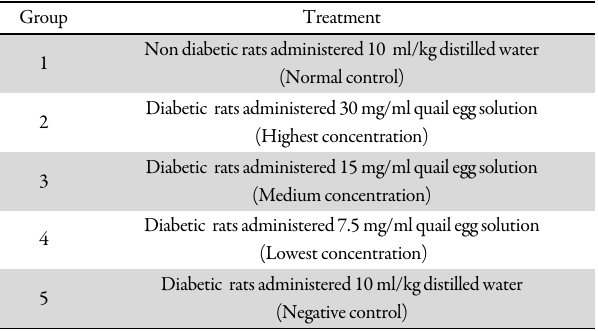
Table 1. Administration of varying concentrations of quail egg solution to Wistar rats